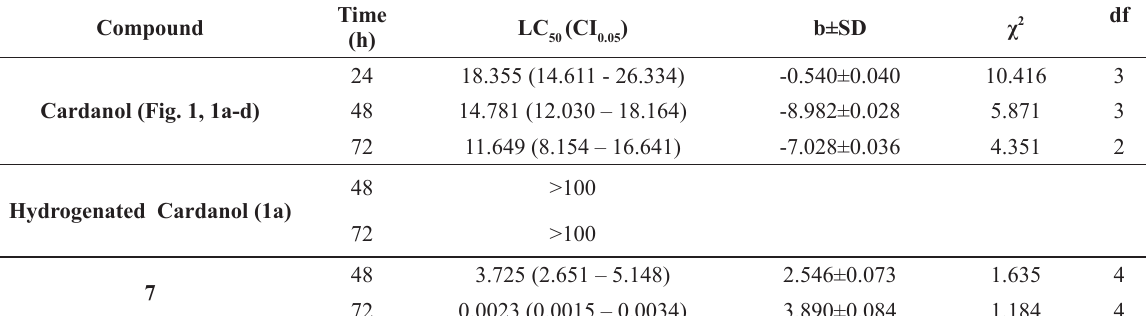
Median lethal concentration (LC ) (mg L -1 , ppm) of cardanol, saturated cardanol (1a) and 7 in different period of 50 exposure to A. aegypti